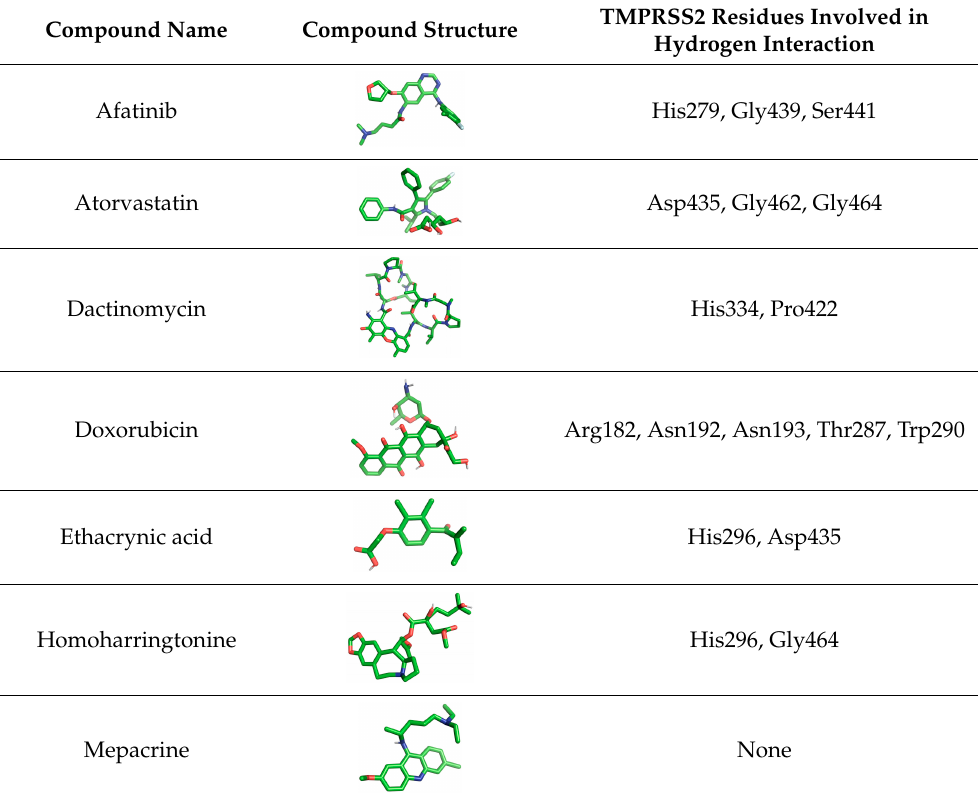
Figure 4. Docking results of 12 candidate compounds for 3CL pro . ( a ) Afatinib, atorvastatin, dactino- mycin and doxorubicin. ( b ) Ethacrynic acid, homoharringtonine, mepacrine and neratinib. ( c ) Niclosamide, rapamycin, tamoxifen and vemurafenib. These results present the pose 1 binding pattern of each compound in the whole protein and polar contact residue view. 3CL pro and compounds are shown in cyan and green, respectively. The polar contacts are marked with yellow dashes. Table 1. Docking affinity for TMPRSS2, molecular structure of individual compounds, and TMPRSS2 residues involved in hydrogen interaction.